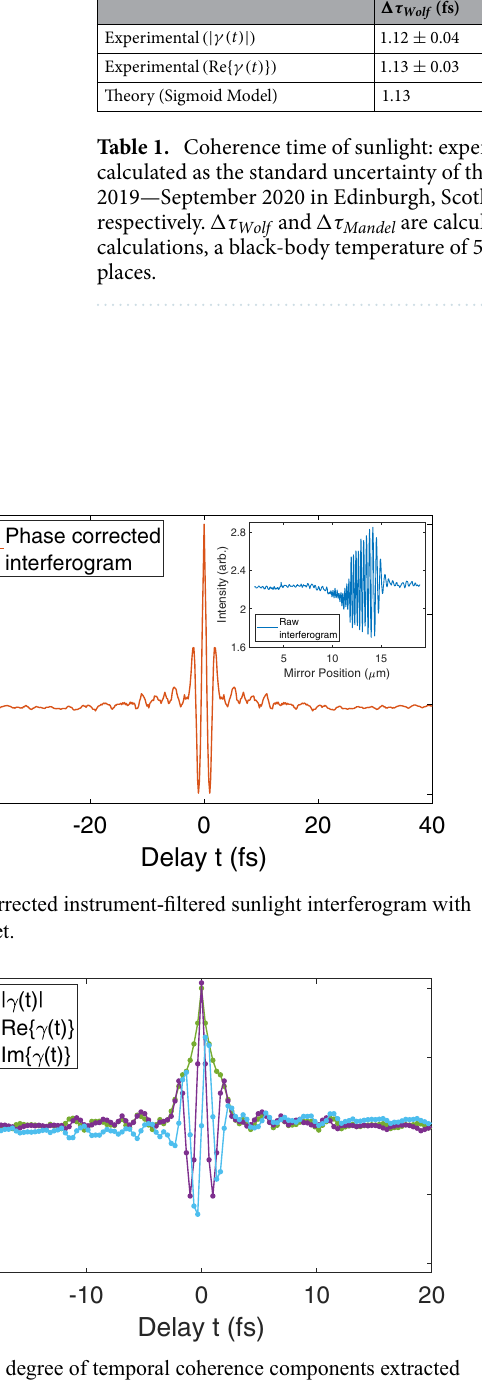
Figure 3. Instrument and chlorophyll-filtered sunlight interferograms. The raw instrument-filtered interferogram was recorded on August 23rd, 2019, at 11:36 and the raw chlorophyll-filtered interferogram was recorded on September 18th, 2020, at 12:54. All interferograms were recorded in Edinburgh, Scotland between August 2019 and September 2020. ( a , b ) both show well defined centre bursts and strong symmetry around the ZPD due to successful phase correction using the Forman method. The interferogram in ( b ) shows more prominent sidelobe oscillations compared to ( a ) due to the additional filtering by the chlorophyll analogous filter package. Raw data for each phase corrected interferogram can be seen in the respective inset. The complex degree of temporal coherence components of ( c , d ) have lower resolution compared to the phase corrected interferograms of ( a , b ), respectively, due to the method by which the γ( t ) is extracted from the single-beam